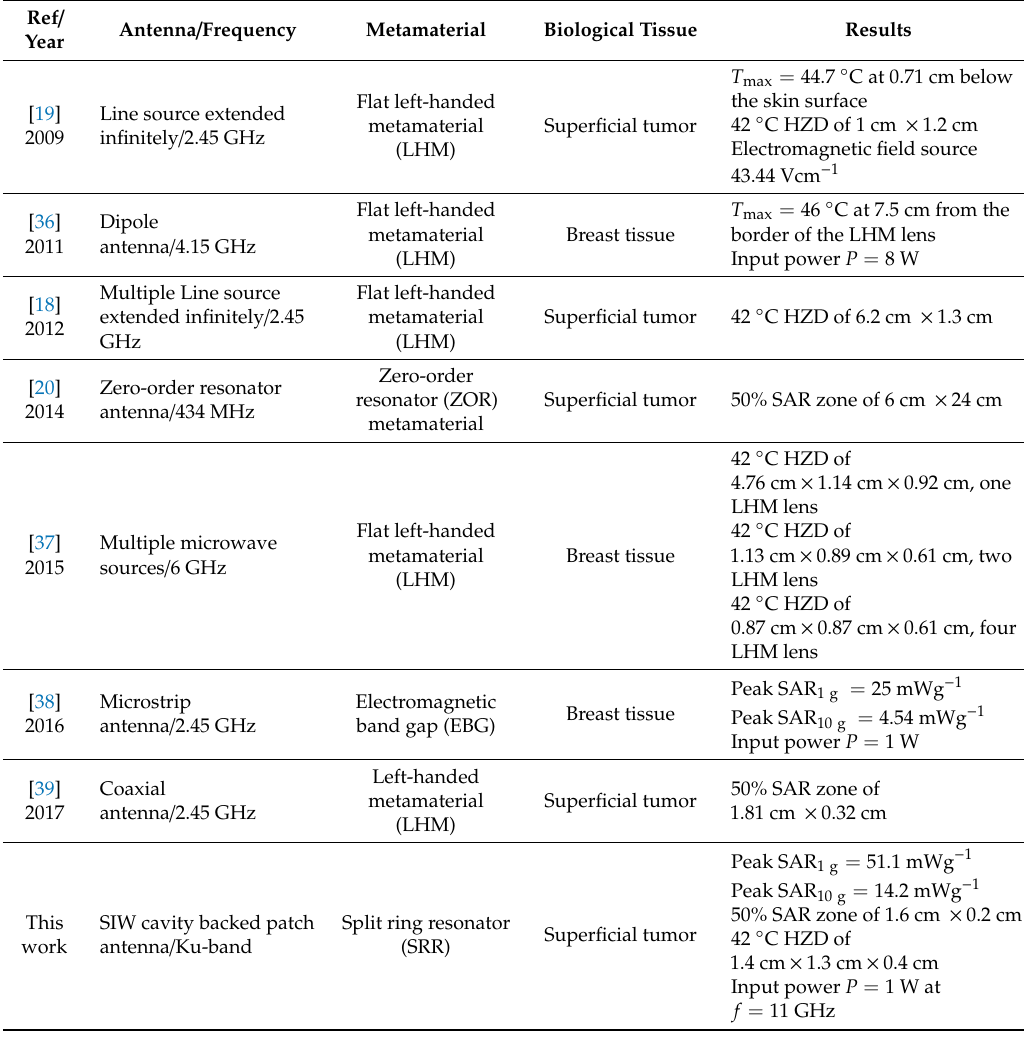
Table 4. Comparison with other microwave applicators for cancer